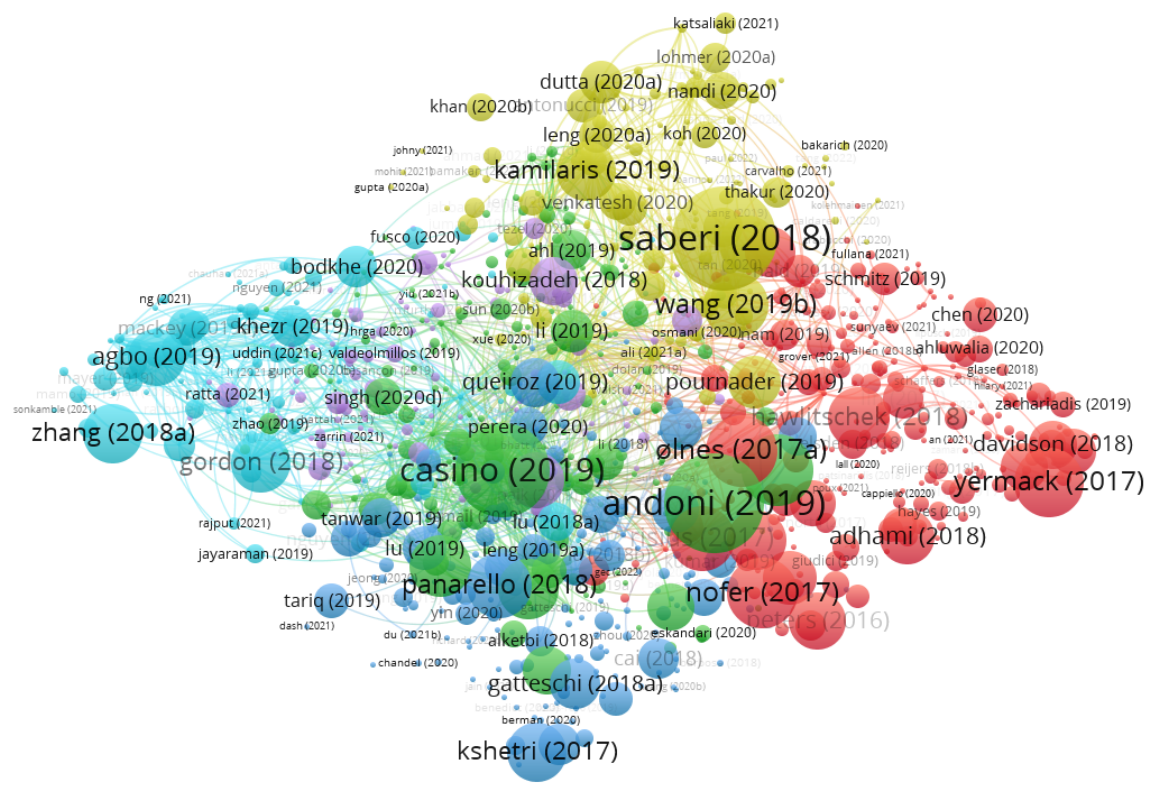
Figure 3. VOSviewer mapping of blockchain technology and smart contracts in decentralized governance systems regarding bibliographic coupling.